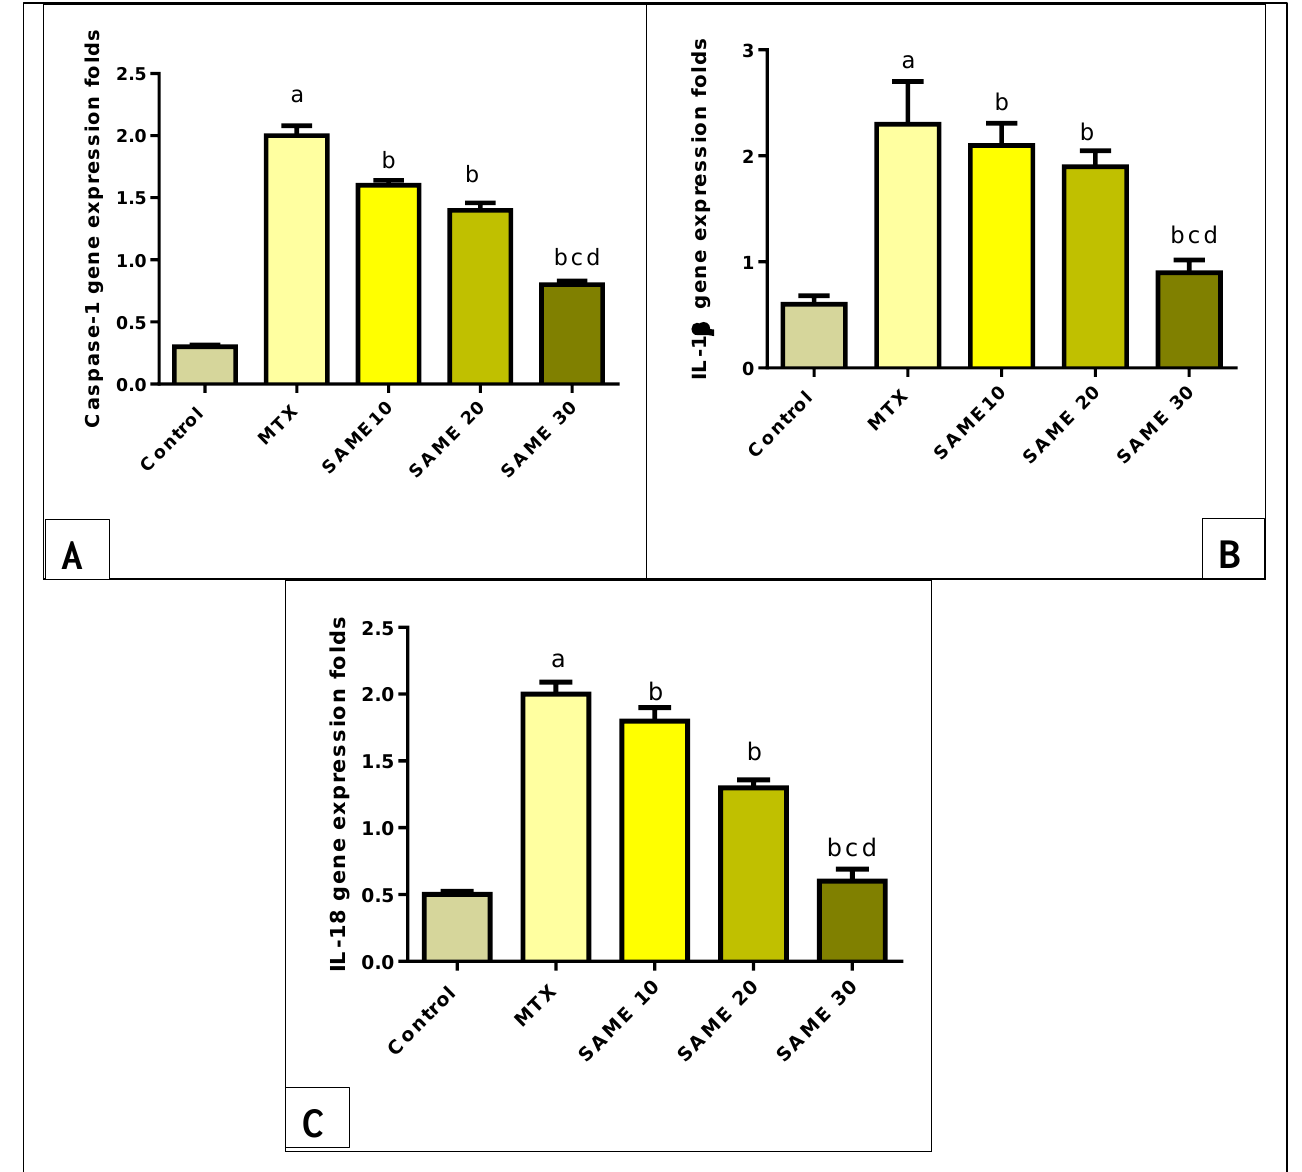
Figure 7. Effect of the SAME pre-treatment on ( A ) Hepatic caspase-1 gene expression level ( B ) Hepatic IL-1β level ( C ) Hepatic IL-18 gene expression level. Hepatotoxicity was induced by a single I.P injection of MTX (20 mg/kg). SAME 10, 20 and 30 were given orally once daily for 5 consecutive days and a single injection of MTX on the sixth day. Data expressed as mean ± SD ( n = 8/group). Significant difference vs. a respective control, b respective MTX group, c respective SAME 10 group, d respective SAME 20 group each at p < 0.05.